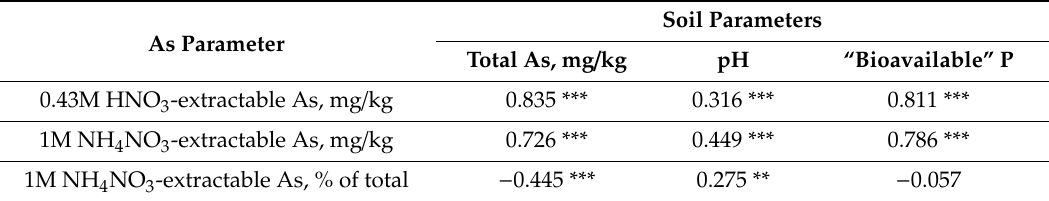
Table 2. Correlations coe ffi cients between soil properties, total As and extractable As in soils, n = 146. The sets of data lacking a normal distribution were normalized by log-transformation. Soil Parameters As Parameter Total As, mg / kg pH “Bioavailable” P 0.43M HNO 3 -extractable As, mg /